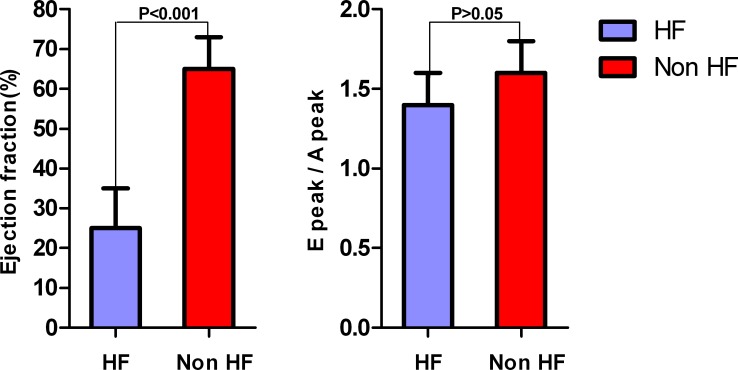
In the heart Doppler examination, the ejection fractions in HF and non-HF patients with sepsis were 25% ± 10.4% and 65% ± 7.5%, respectively, a significant difference (P < 0.001); the E peak/A peak of the 2 groups were normal and not significantly different (1.4 ± 0.2 cf. 1.6 ± 0.2).The results suggested a left ventricle systolic dysfunction in all heart failure patients with sepsis.